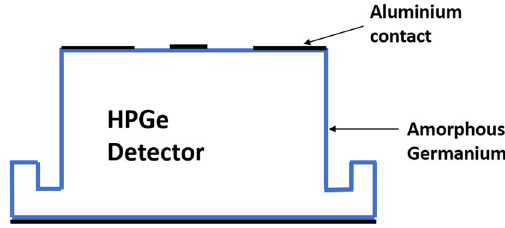
Fig. 2 Shown is a Ge detector with a guard ring structure